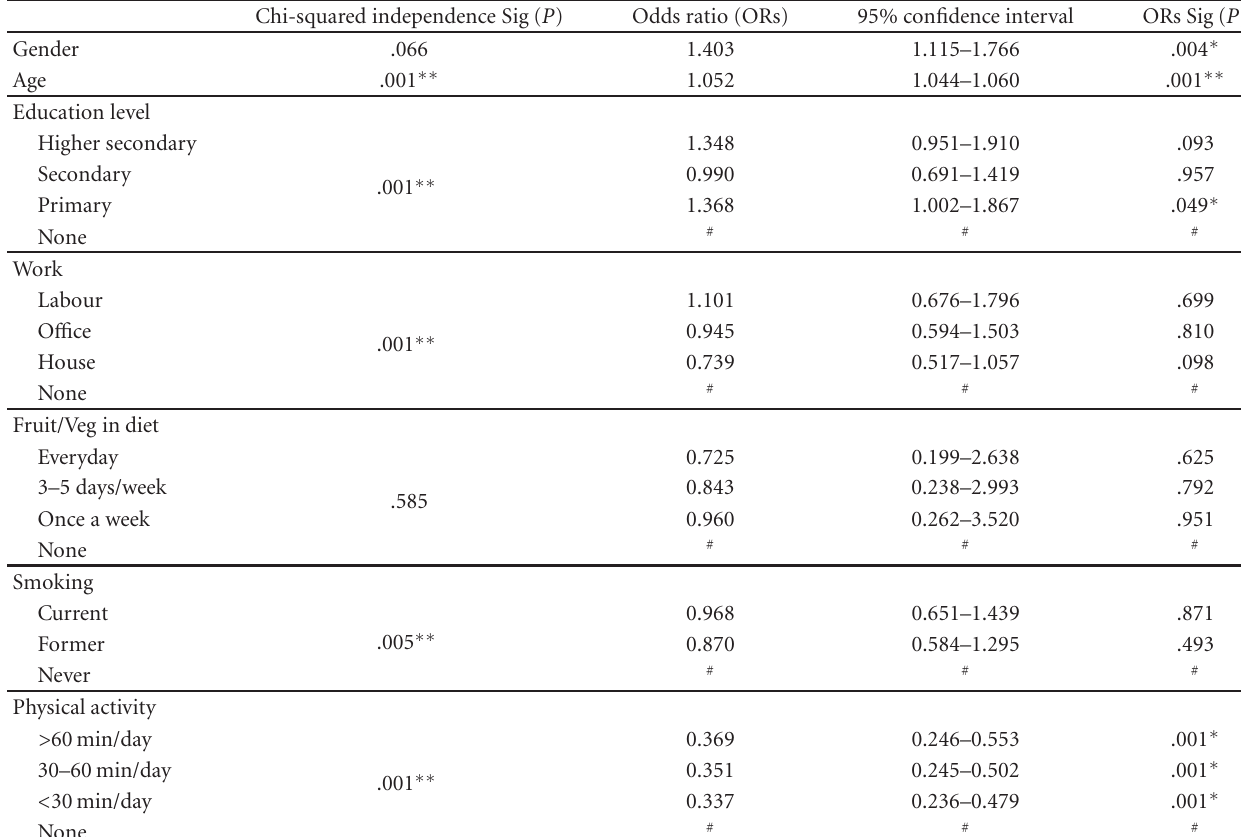
Table 7: Chi-squared significance for the independence, odds ratios and 95% confidence interval of age, gender and life style factors in the prevalence of metabolic